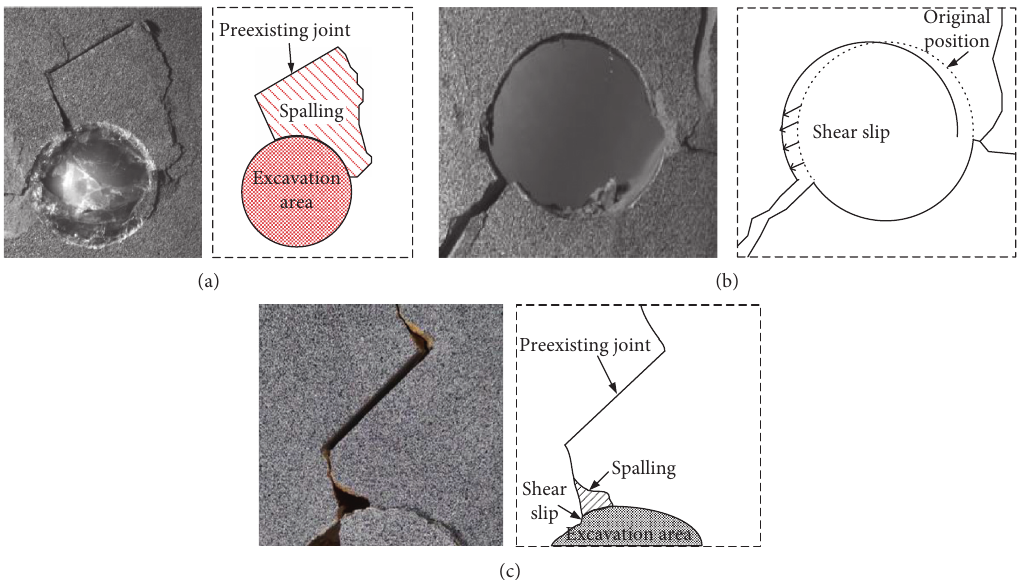
Figure 10: Failure modes between the hole and joint. (a) Type I, (b) Type II, and (c) Type